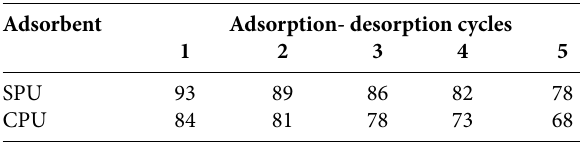
Table 4. Maximum Pb (II) ion adsorption in adsorption-desorption cycles by SPU and CPU